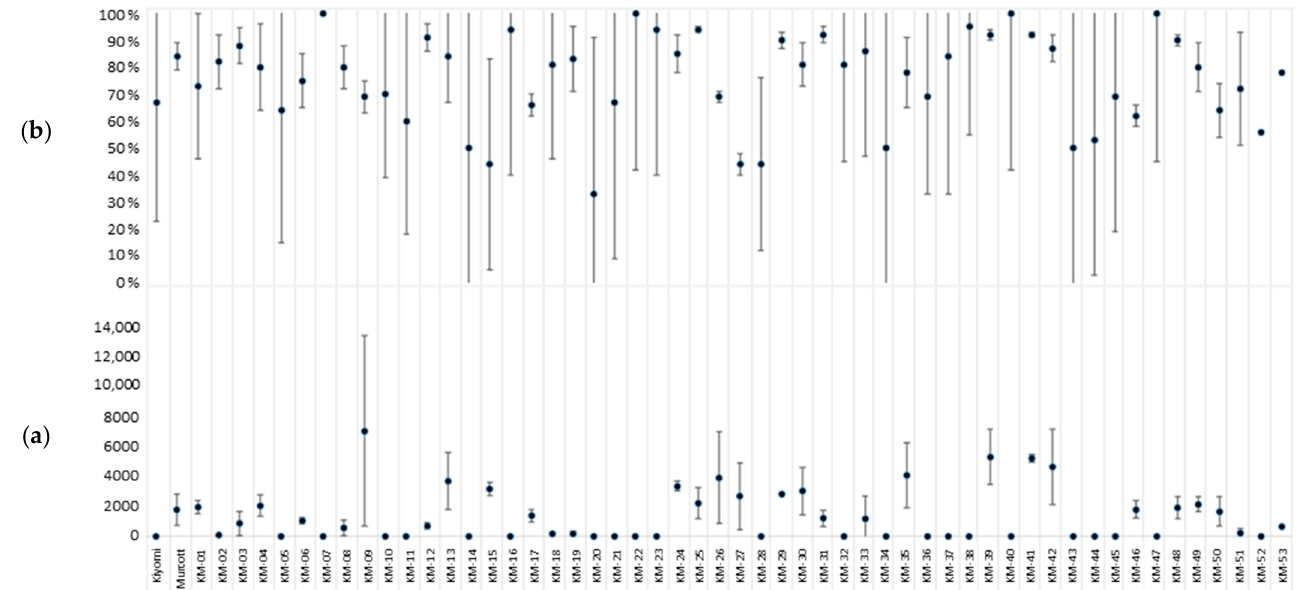
Figure 1. Average and standard deviation representation of ( a ) the number of pollen grains per anther and ( b ) the percentage of apparent pollen fertility in the ‘Kiyomi’ × ’Murcott‘ offspring phenotyped for male sterility. The x -axis indicates the name of the parents and hybrids.